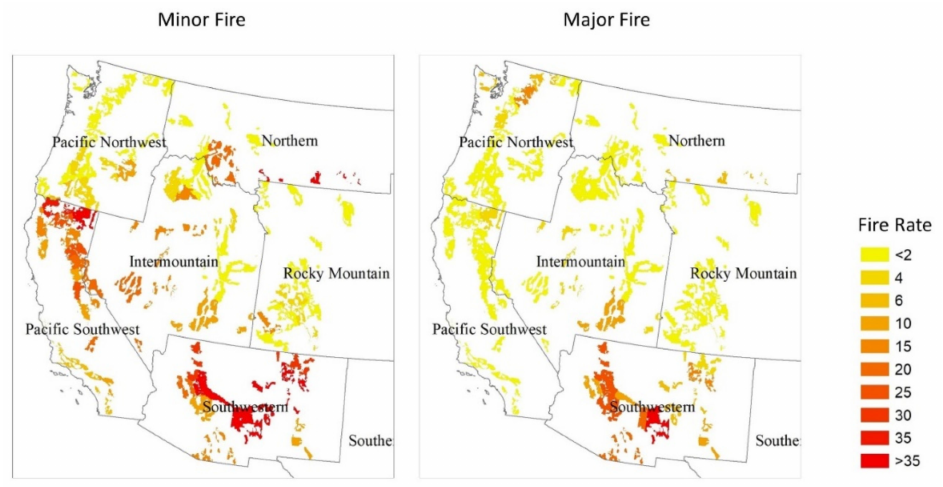
Figure 2. Total rate of minor and major forest fires in western U.S. forests over the historical period (1986–2015).